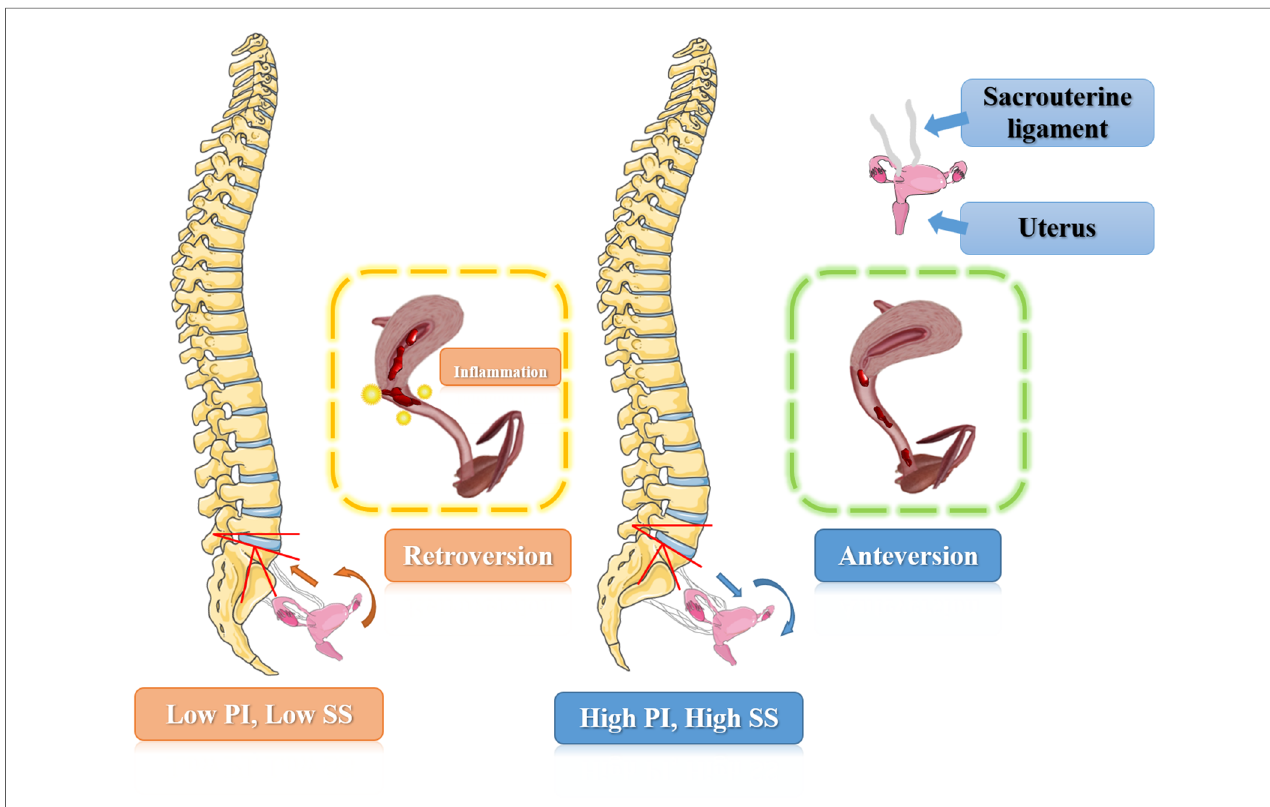
FIGURE 6 The schematic illustration of possible pathological mechanisms how spino-pelvic alignment parameters affect the primary dysmenorrhea